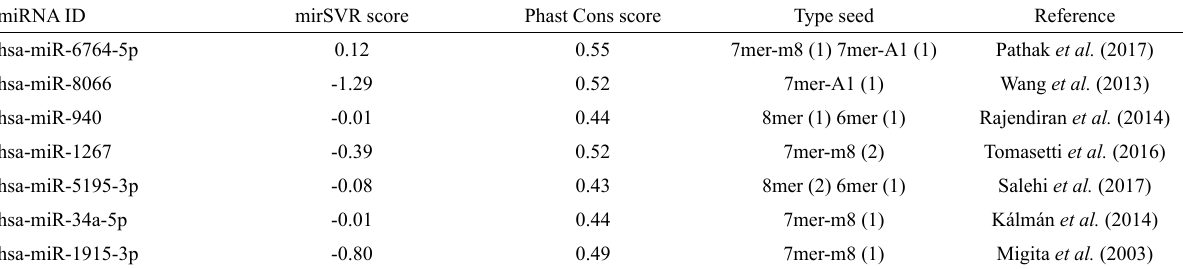
Table 4 – Prediction of miRNA target sites in BTD according to mirSVR and TargetScanHuman algorithms. miRNA ID